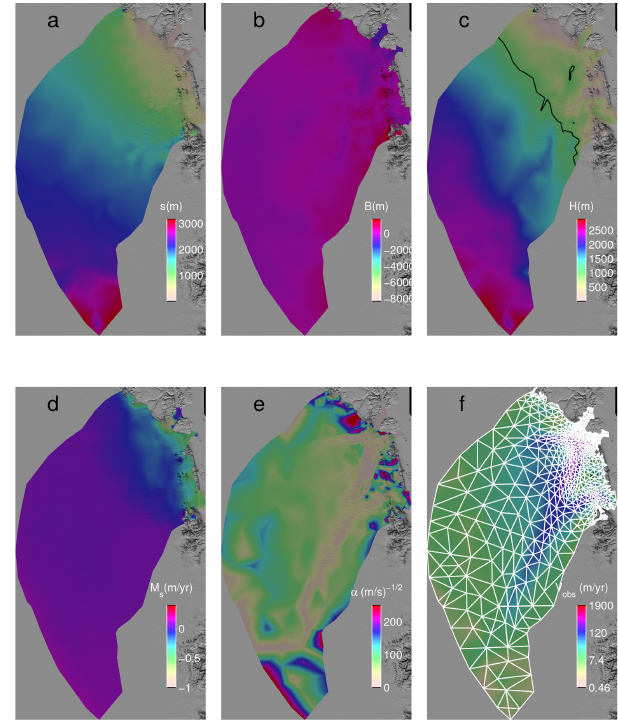
Figure 3. (a) 2007 surface height from Howat et al. (2014); (b) bedrock elevation inverted using the mass-conserving ap- proach (Morlighem et al., 2011, 2013a), existing bedrock data from Thomsen et al. (1997) and Christensen et al. (2000), IceBridge Multichannel Coherent Radar Depth Sounder (MCoRDS) ice thickness data (Allen, 2011) and InSAR surface velocities from Rignot and Mouginot (2012). (c) Ice thickness inferred from (a) and (b) . In black, 1000m contour level. (d) 1971–1988 aver- aged yearly surface mass balance M s (myr − 1 ) from Box (2013). (e) Drag coefficient α (m − 1 / 2 s 1 / 2 ) inverted using 2008 InSAR- derived surface velocities from Rignot and Mouginot (2012). (f) Model mesh, superimposed on 2008 observed surface velocity (myr − 1 ) derived from InSAR (Rignot and Mouginot,